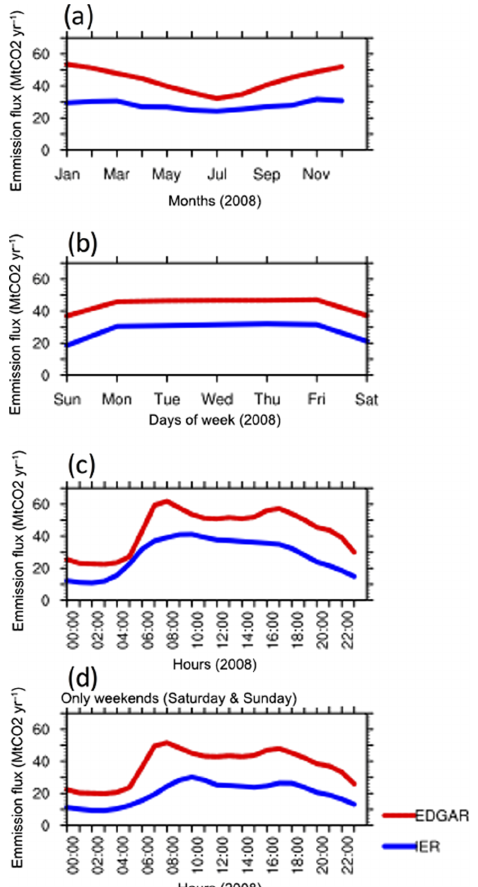
Figure 3. Temporal variability of EDGAR and IER emis- sion fluxes, aggregated over the target region around Berlin ( ∼ 100km × 100km) averaged for different timescales for the year 2008: (a) monthly, (b) weekly, and (c, d) hourly. Panel (d) shows the values representing only weekends, while (c) represents all days of the week. Hours are in UTC (local time CET = UTC +